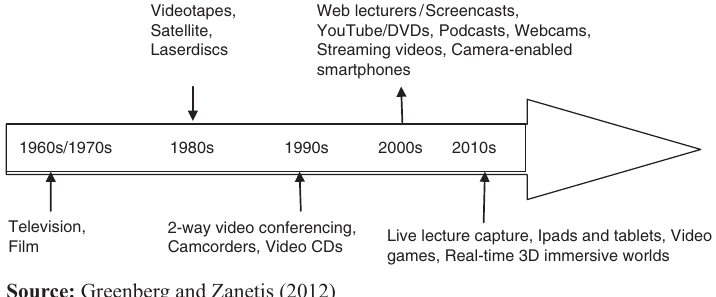
Figure 2. Timeline on the